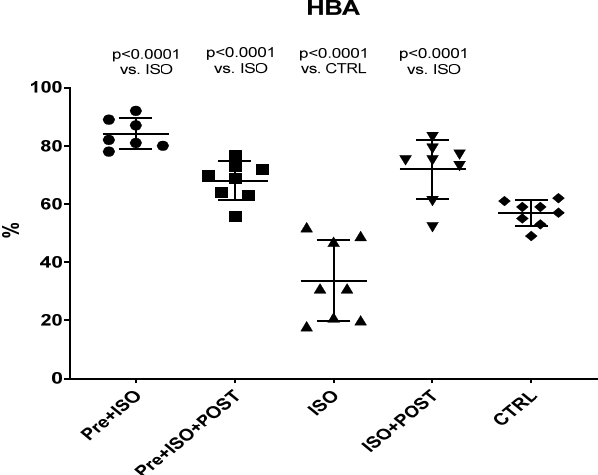
Figure 2. Changes (%) in the quality and maturity of the semen as a result of isoproterenol treatment and exercise training. The results are shown as mean ± S.D., n = 7–8/group, one-way ANOVA, Tukey’s post-test. Significant differences between treatment groups are shown with exact p values. HBA = Hyaluronan Binding Assay, PRE = Pre-swimming, ISO = Isoproterenol injection, POST = Post-swimming, CTRL = Control group.